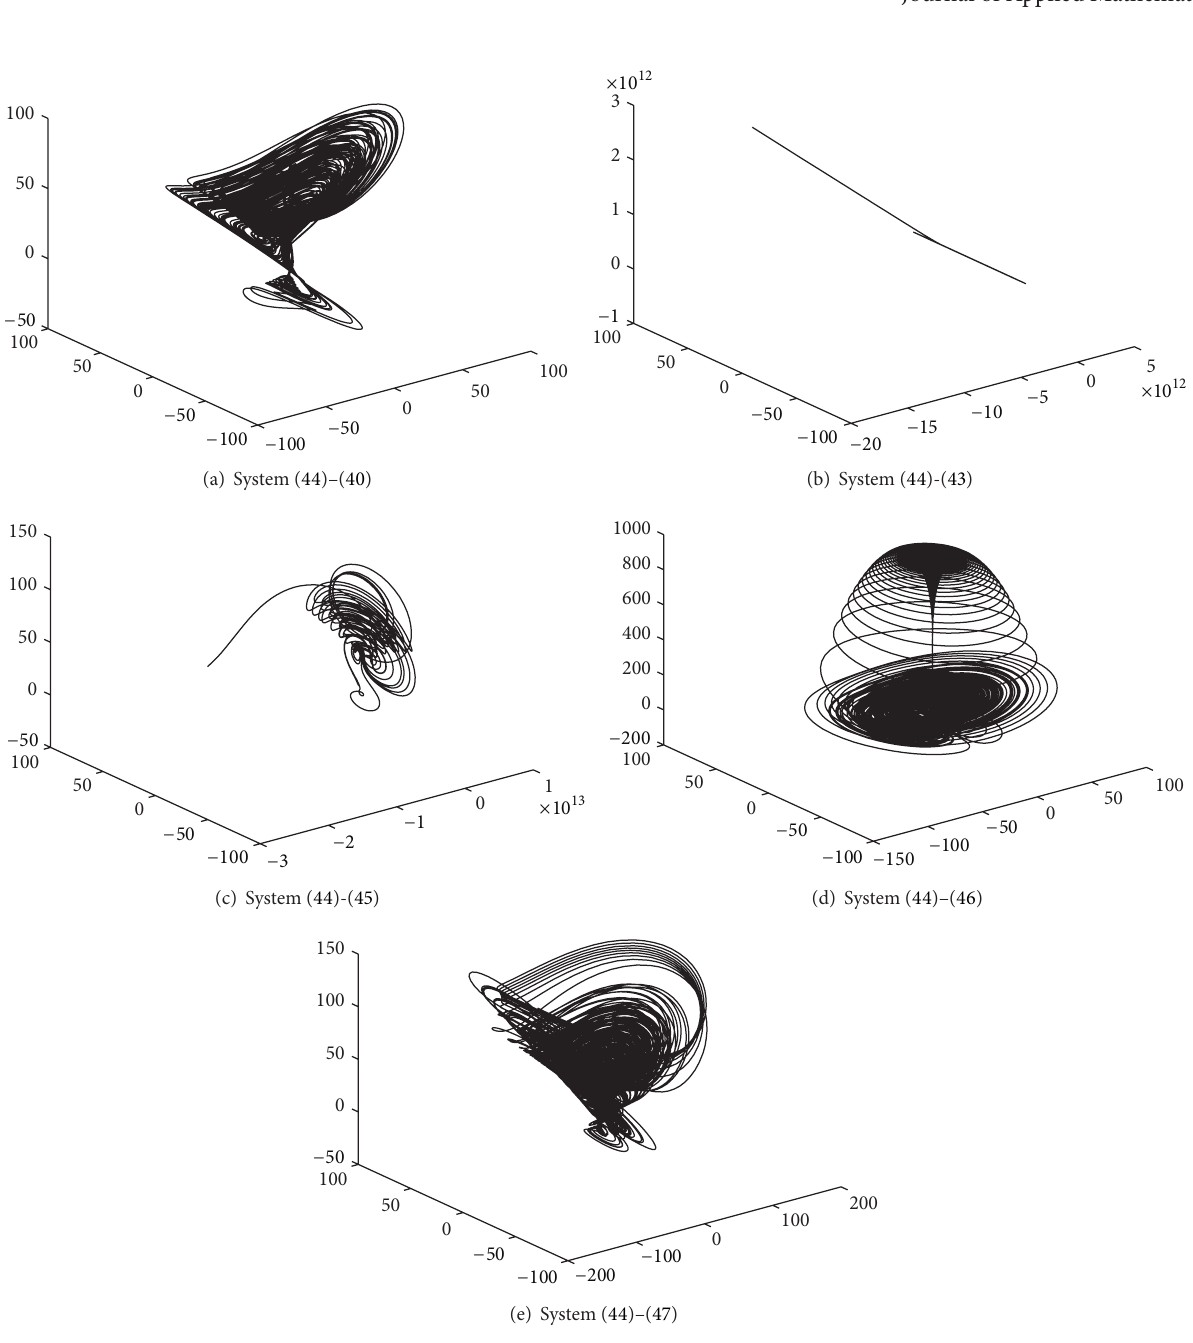
Figure 9: Switched system between Example (44) and